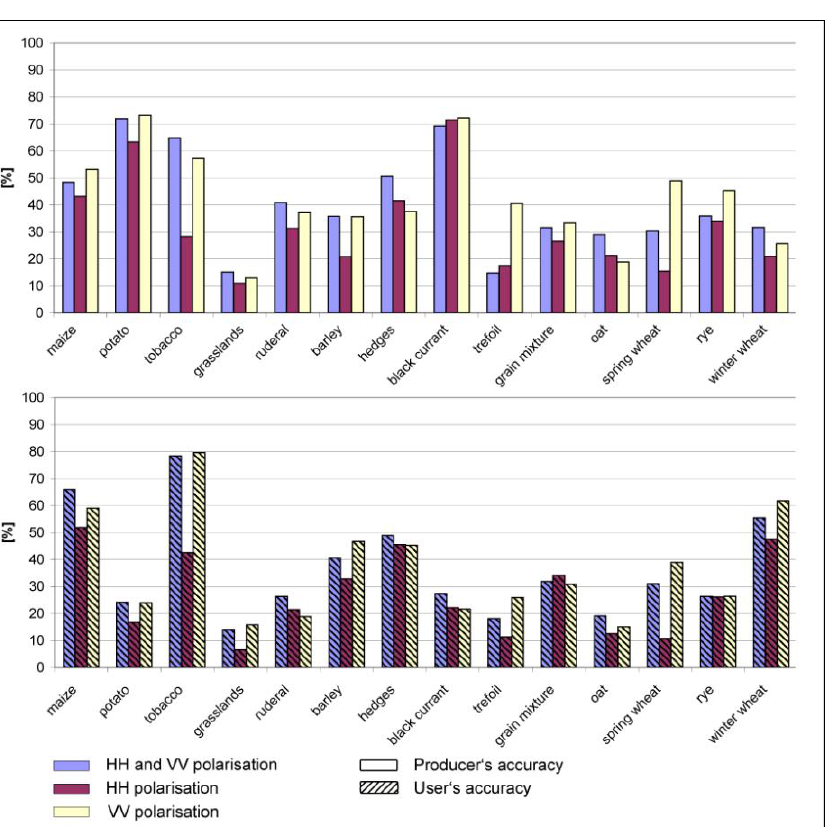
Figure 9. Producer‘s and user‘s accuracies for single classes in the Gorajec